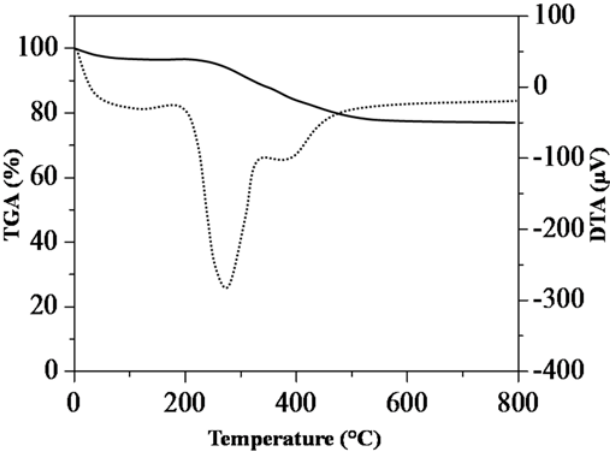
Figure 3. Thermogravimetric analysis ‐ differential thermal analysis (TGA ‐ DTA) thermogram of SG ‐ HRS.